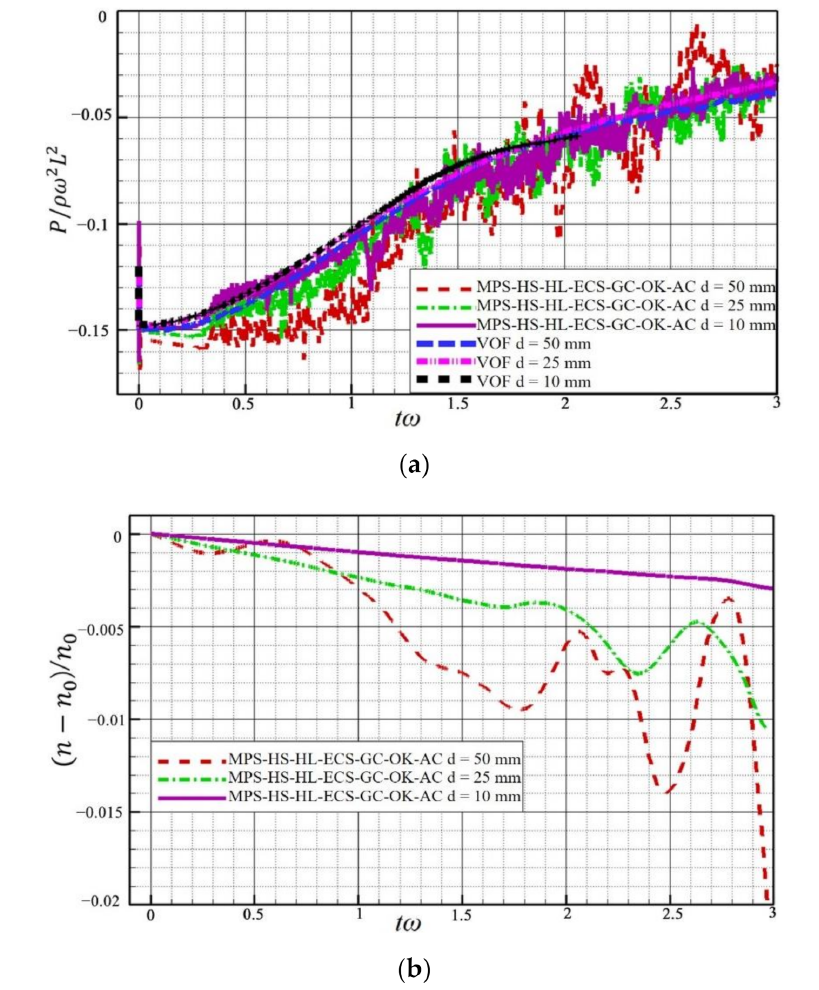
Figure 4. Time histories of the pressure and particle number density of a particle initially located at the center of the square fluid patch with different particle spaces in the 2D case: ( a ) pressure; ( b ) particle number